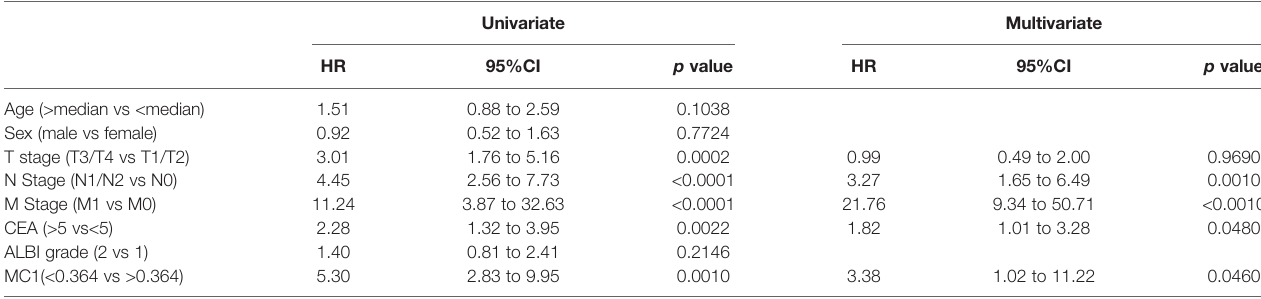
TABLE 5 | Association between MC1 and prognosis in patients with CRC.